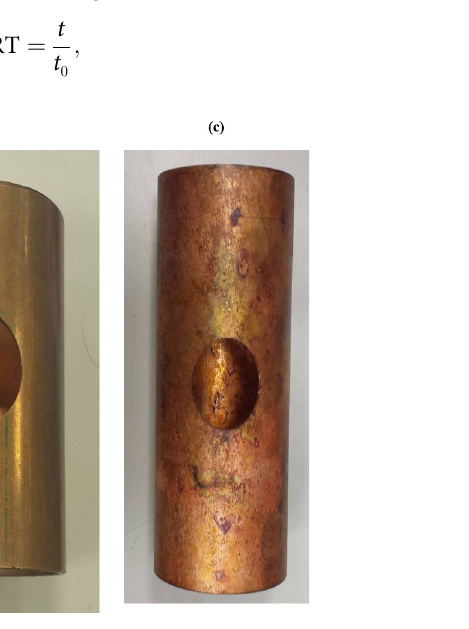
Fig 6. Specimen preparation: (a) Cut (b) Drilled (c)